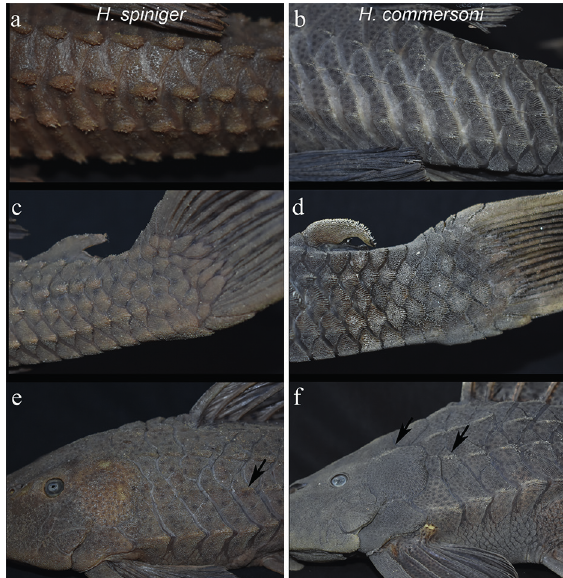
Figure 6 - Details of diagnostic characters between ( a, c, e ) H. spiniger and ( b, d, f ) H. commersoni . ( a, b ) lateral ridges; ( c, d ) lateral ridges in caudal peduncle; ( e, f ) mid lateral-rigde origin and rigde in temporal